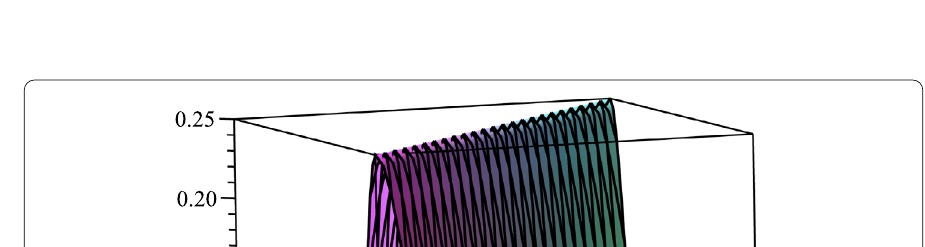
Figure 1 The solution of the mZK with k = 1, z = 2 x